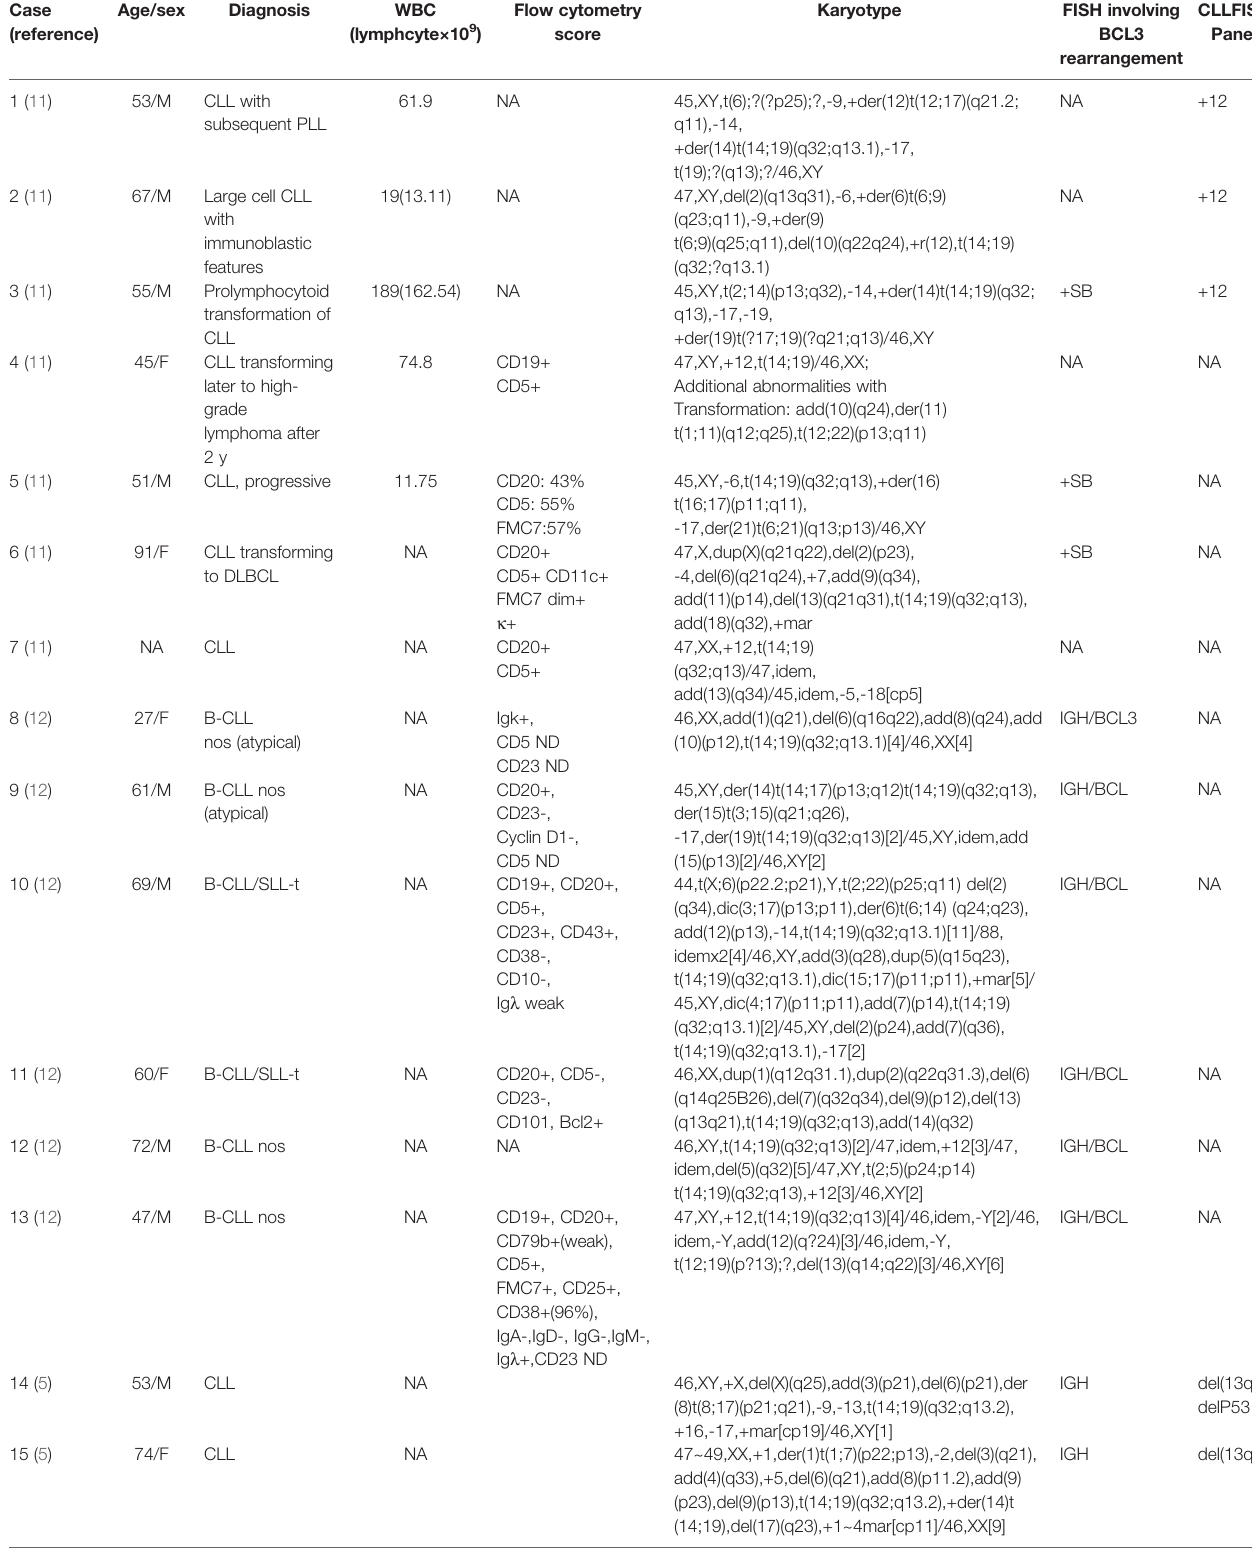
TABLE 3 | Clinical and laboratory data of all cases with t(14;19) accompanied by high-CK in previous studies. Case (reference)